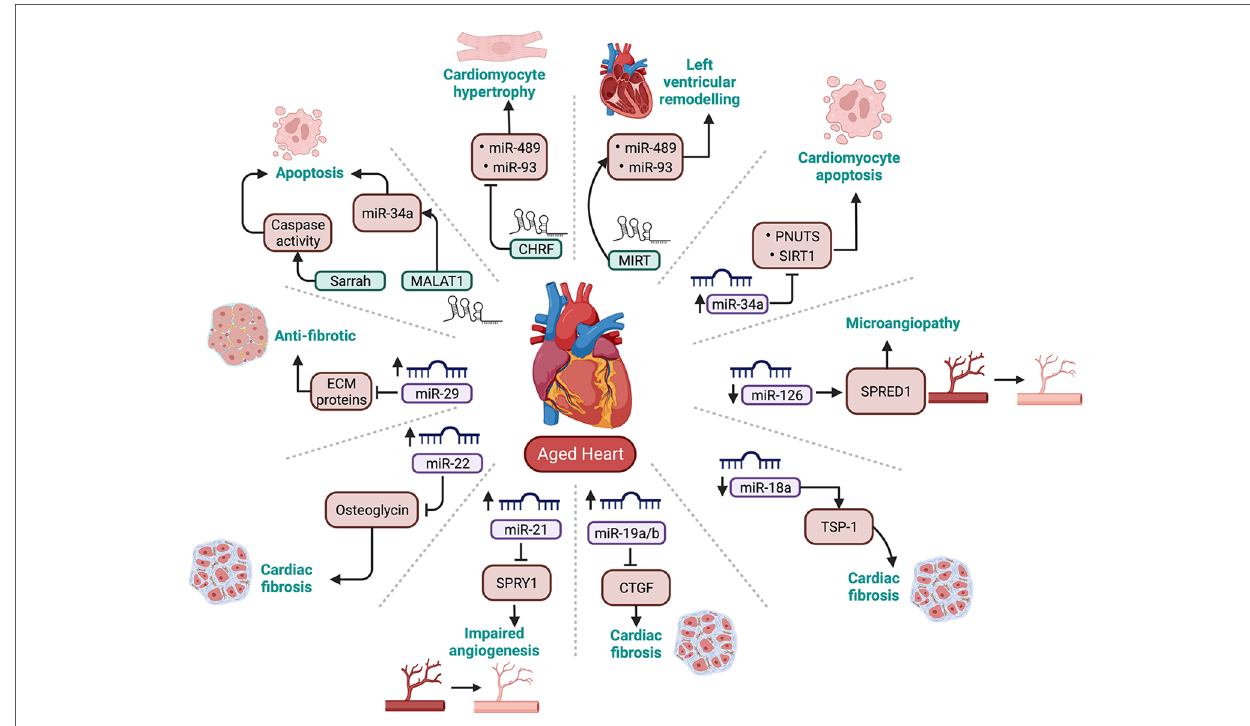
FIGURE 3 Summary of cardiovascular enriched miRNAs and lncRNAs that are dysregulated with ageing. PNUTS, phosphatase-1 nuclear targeting subunit; SIRT-1, sirtuin 1; TSP-1, thrombospondin-1; CTGF, connective tissue growth factor; SPRY1, sprout protein homolog 1; SPRED1, sprouty related EVH1 domain containing 1; ECM proteins, Extracellular matrix